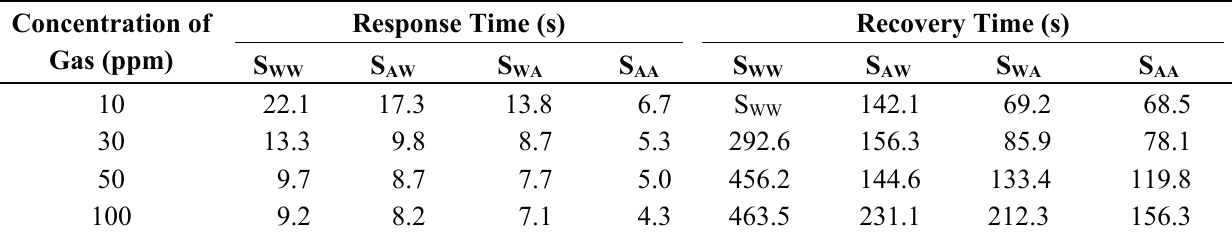
Table 3. Response speed of different sensors under various acetone gas